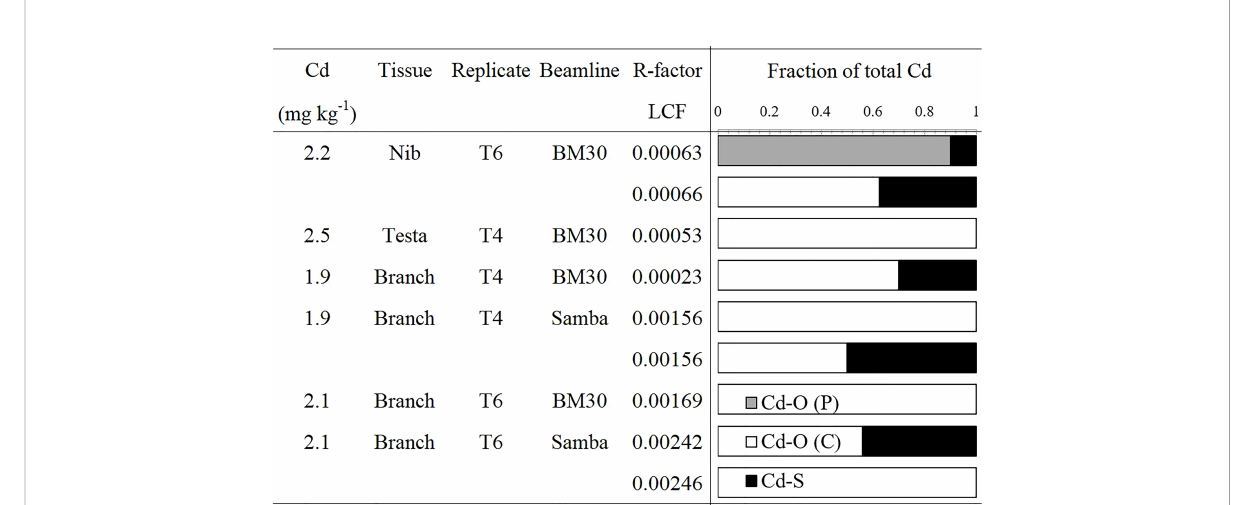
FIGURE 4 Proportion of Cd species in cacao tissues determined by XANES. Linear combination fi ts were done in the [E 0 -20; E 0 +80] eV range. Fit quality was examined by the R-factor. If the R-factor increases <10%, the fi ts are considered of equivalent quality and both results are shown in the fi